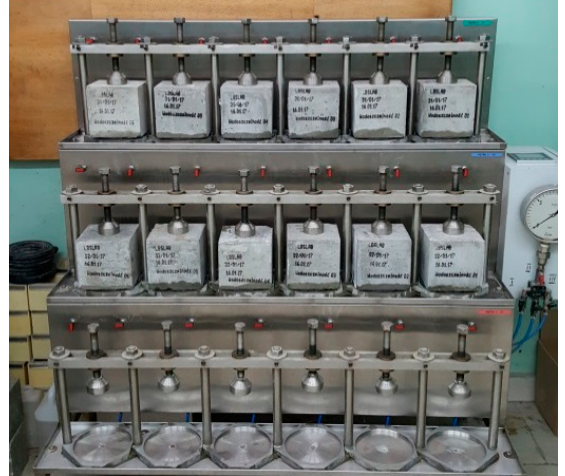
Figure 3. Water-tightness test of concretes.